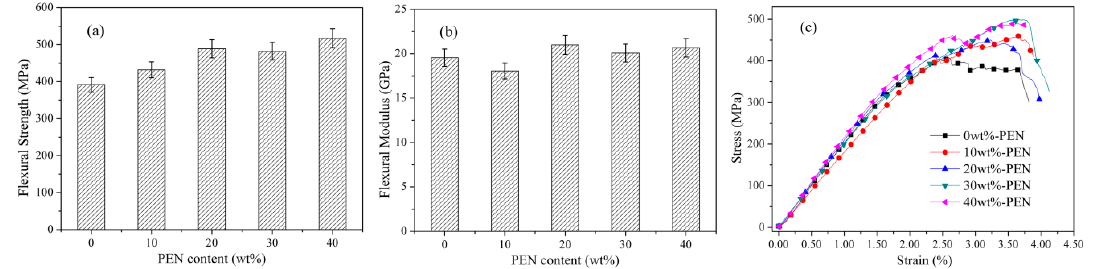
Figure 3. Mechanical properties of the various composite laminates: ( a ) the flexural strength, ( b ) the flexural modulus and ( c ) stress and strain curves.